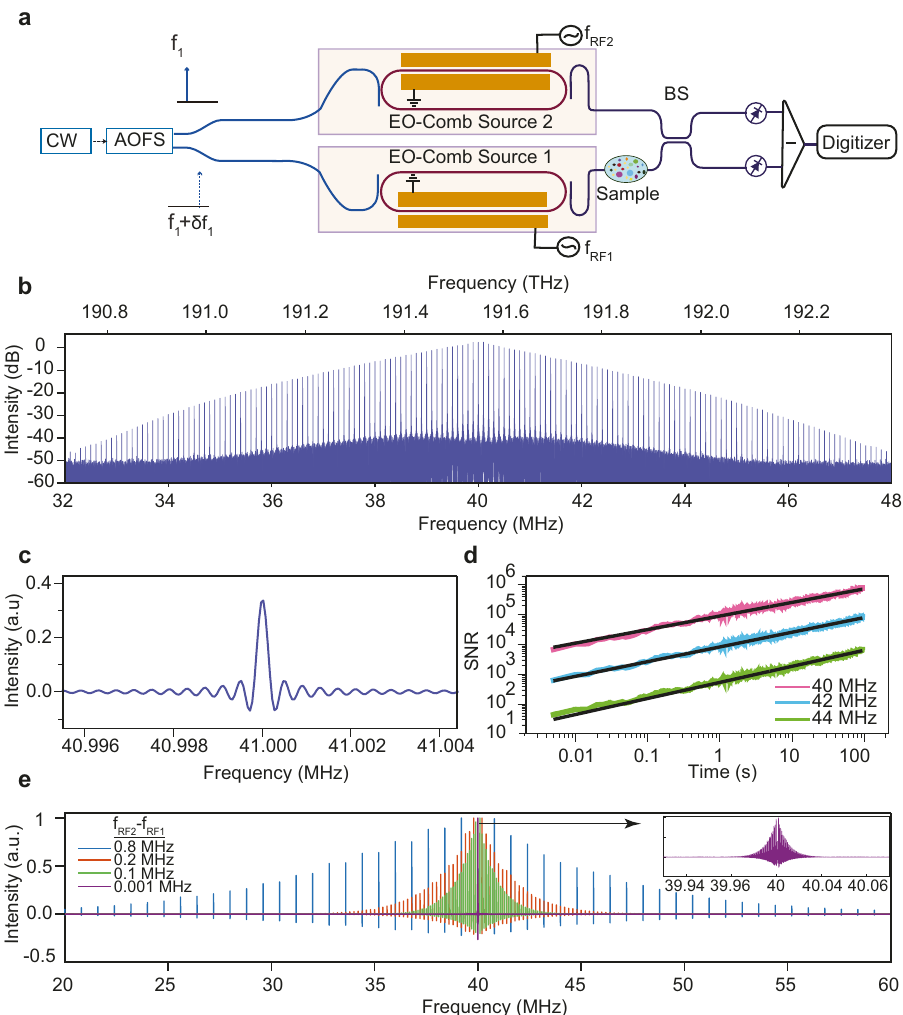
Fig. 2 Experimental results of the microring electro-optic (EO) dual-comb spectrometer. a The setup for dual-comb spectroscopy for the acetylene gas cell at near atmospheric pressure with two EO-Comb sources (CW: Continuous-wave laser, AOFS: Acousto-optic frequency shifter; BS: Beam splitter). b Apodized dual-comb spectrum ( f 1 = 191.55 THz and δ f rep1 = 40 MHz) with the measurement time of 95 s. 19,000 interferograms (5 ms each) are acquired and processed, and the amplitude spectra are averaged. The two EO combs are driven with microwave frequencies with f RF1 = 10.45 GHz and f RF2 - f = 0.1 MHz. The signal-to-noise ratio (SNR) of the center comb line is 8 × 10 5 , and the average SNR of 160 comb lines is 1 × 10 5 . c An unapodized RF1 individual comb line, near 41 MHz in ( a ), is shown featuring a cardinal sine instrumental line shape. d The evolution of the SNR of three selected comb lines from ( a ) at 40 MHz, 42 MHz, and 44 MHz over the measurement time. Their linear fi tted slopes (black line) are 0.46, 0.49, and 0.54, respectively, indicating that SNR increases with the square root of the measurement time. e The recon fi gurability of the microring EO dual-comb system. The interferogram refresh rate ( f RF2 -f RF1 ) is varied on demand at 0.800, 0.200, 0.100, and 0.001